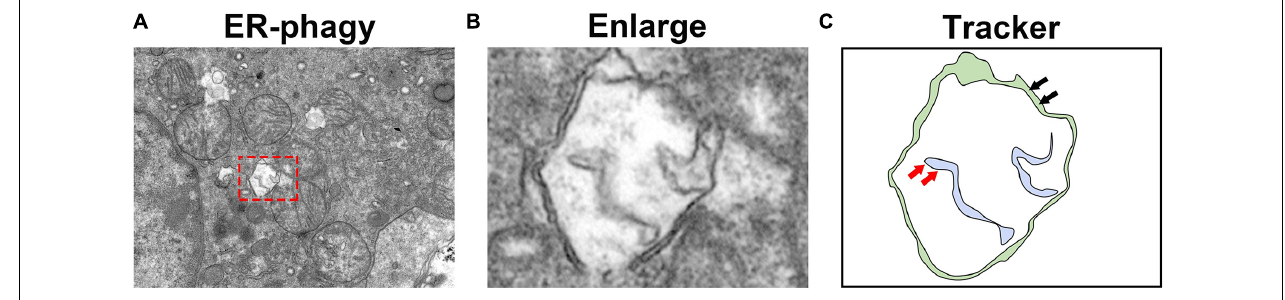
FIGURE 4 | Observation of ER-phagy by transmission electron microscopy. (A) Transmission electron microscopy images of the mouse kidney. (B) The autophagosomes involved in ER-phagy. (C) The localization pattern of autophagosomes in ER-phagy (the red arrow represents the ER membrane, and the black arrow represents the autophagosome